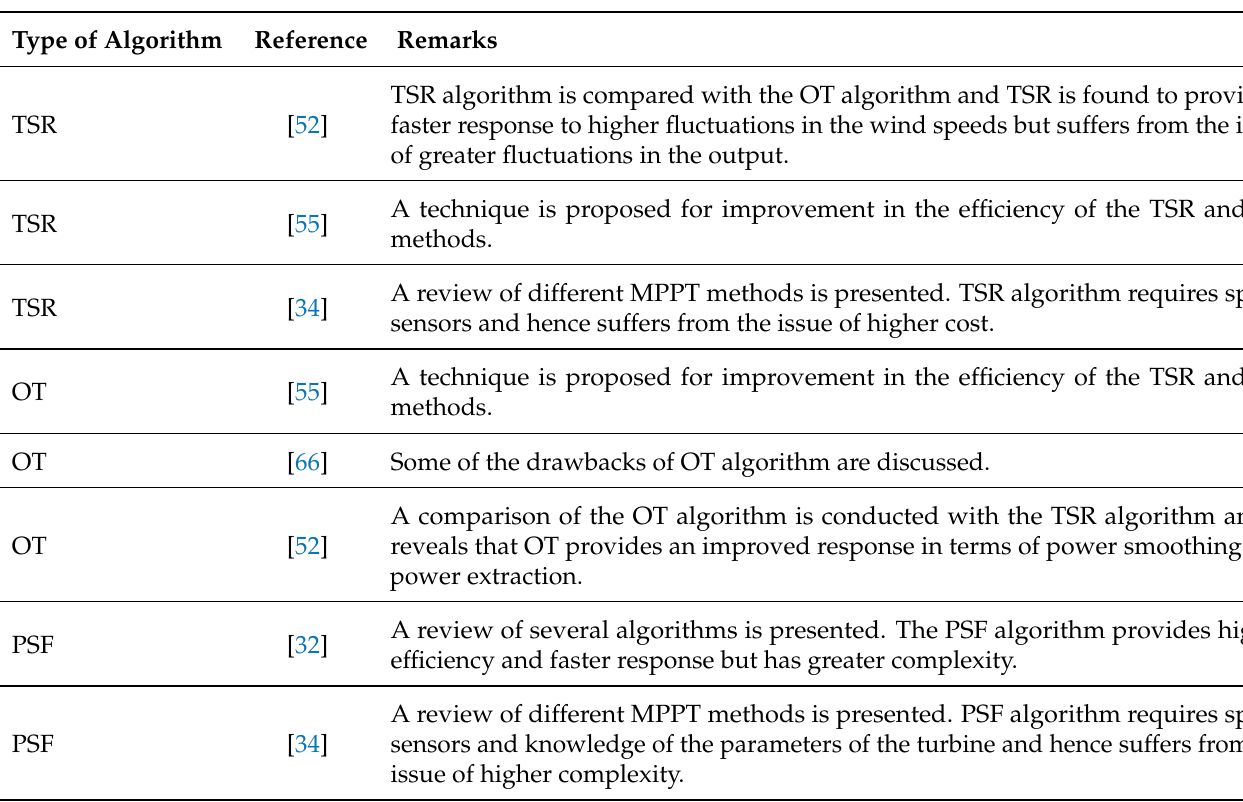
Table 2. Summary of references for IPC based MPPT